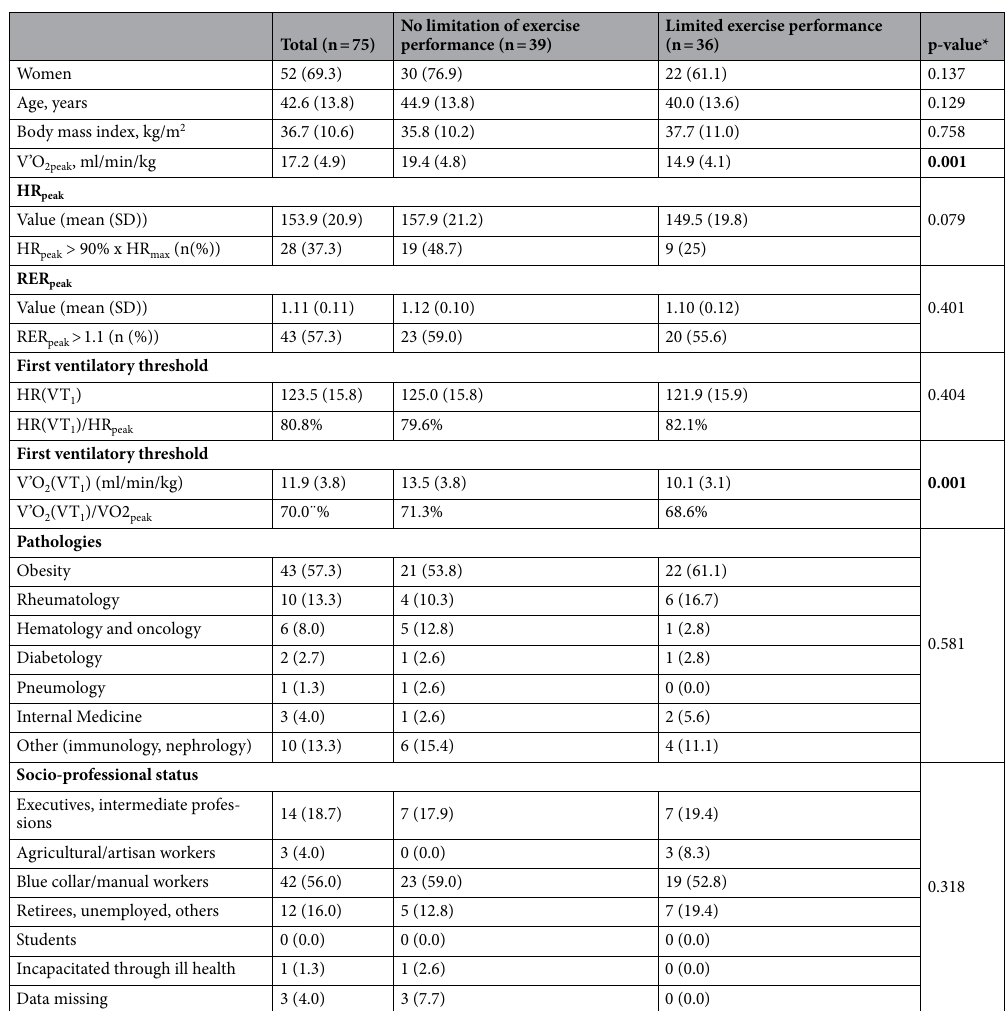
Table 1. Baseline demographic and clinical characteristics (n = 75). Significant values are in bold. Data are presented as n (%) for dichotomous variables, mean (SD) for continuous demographic variables. *We use the student T test to compare age and body mass index, and chi-square test or Fisher’s exact test for other variables.